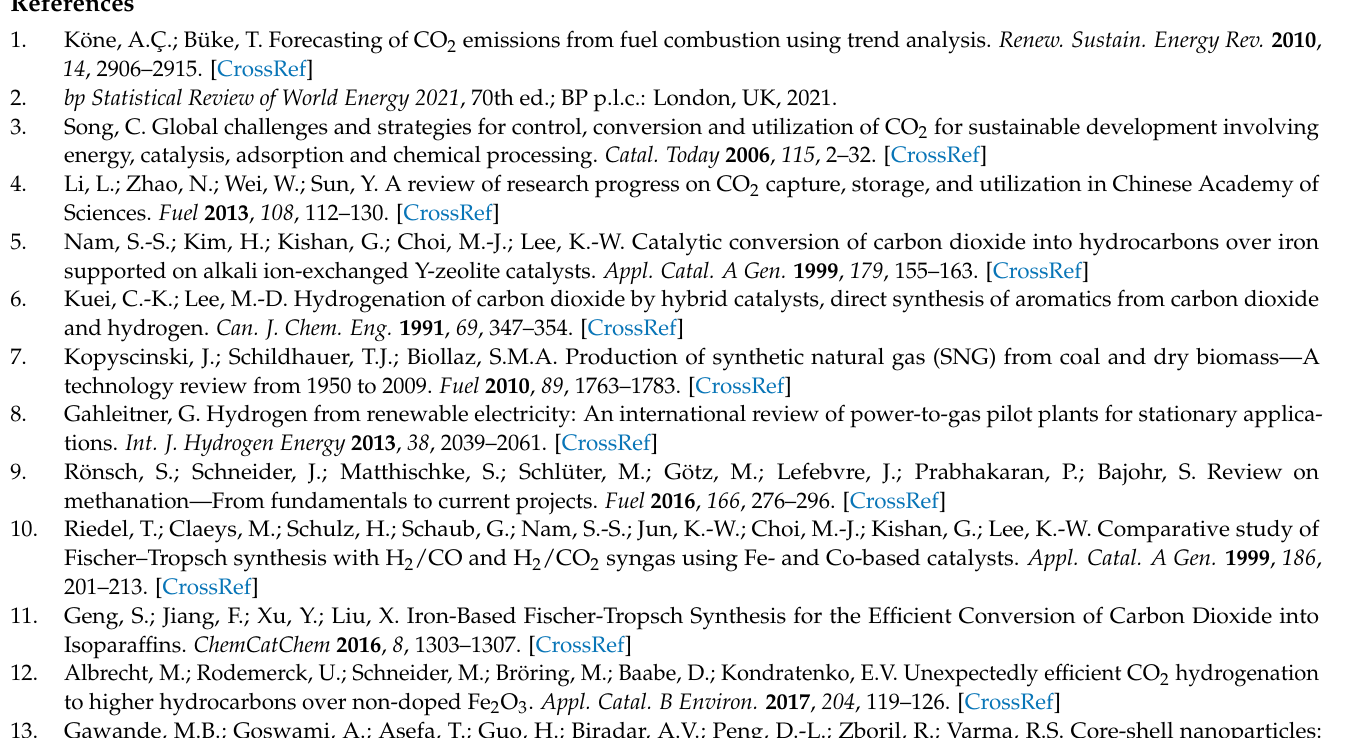
experiments; Figure S2: PXRD pattern of as-made Fe@SiO 2 core–shell catalyst; Figure S3: TPR pattern of as-made Fe@SiO 2 core–shell particles; Figure S4: Results of evaluation of higher hydrocarbon (C 2+ ) byproducts during CO hydrogenation; Figure S5: Arrhenius plots and apparent activation energies; Figure S6: Extent of reaction of CO 2 conversion during CO hydrogenation; Figure S7: Extent of reaction of the Boudouard reaction and CO 2 hydrogenation; Figure S8: Extent of reaction of CO conversion during CO 2 hydrogenation; Supporting Information II—value